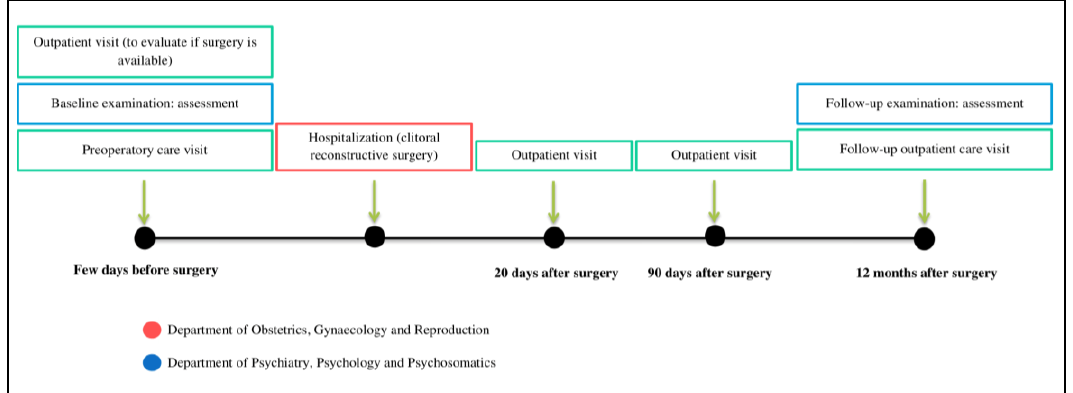
Figure 1. Clinical procedure timeline.